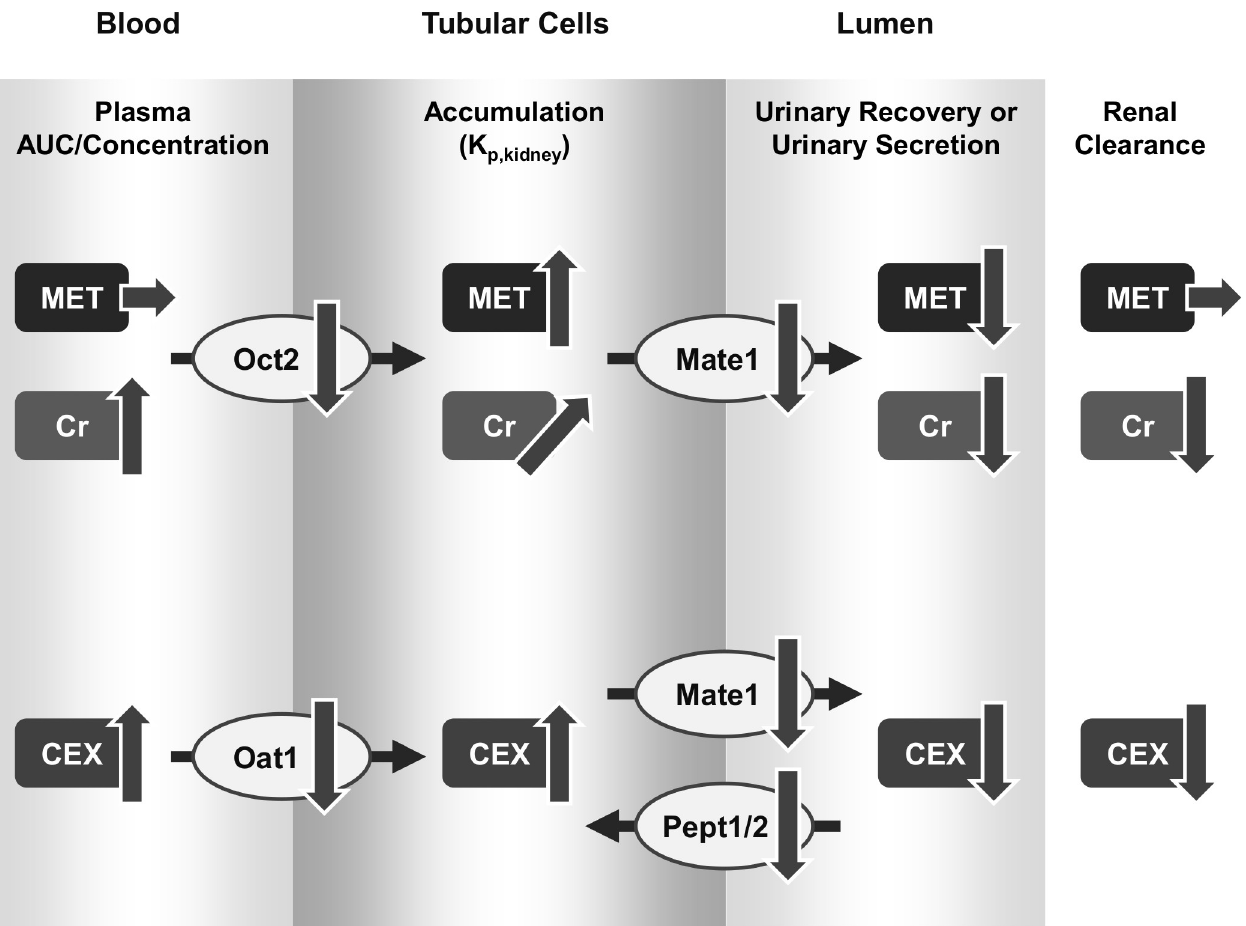
Fig 7. Schematic figure recapitulating the effects of hyperuricemia on mRNA and protein expressions of transporters in kidney, as well as its putative consequences regarding to the pharmacokinetics. Changes in plasma AUC and concentration of each drug are shown in the blood column. Changes in kidney accumulation (K p,kidney ) of each drug are shown in the tubular cells column. Changes in urinary secretion of each drug are shown in lumen column. In regard to transporters, changes in mRNA and/or protein expression are shown. Arrows show changes as follows: " , increase; # , decrease; ! , no change. Metformin and creatinine are substrates of Oct2 and Mate1. Cephalexin is a substrate of Oat2, Mate1 and Pept1/2. MET, metformin; Cr, creatinine; CEX, cephalexin.